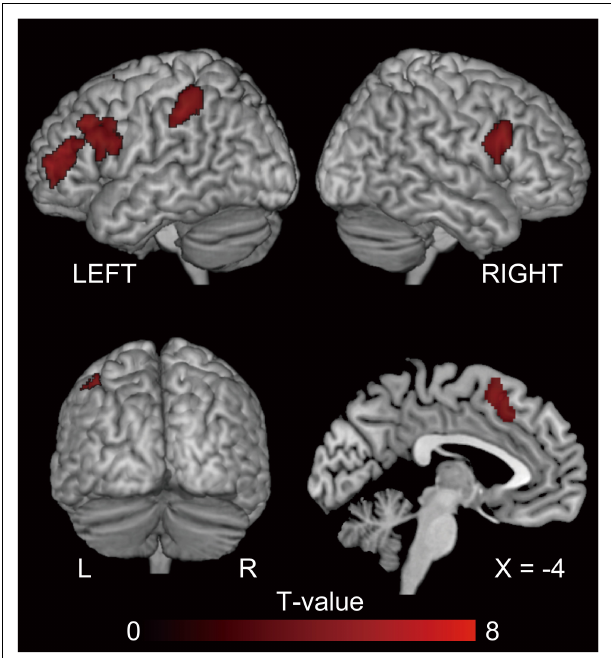
FIGURE 5 | Regions showing greater activation in DO than in PO (nD > nP). P, D, and N represent Prepositional Object trials (PO), Double Object trials (DO), and No structure trials, respectively. Activation in these regions reflect a greater processing load for grammatical encoding in DO compared to PO production. FWE-corrected p < 0.05 at the cluster level, with a height threshold of p < 0.001, uncorrected. The activation is superimposed on the high-resolution T1 weighted MR